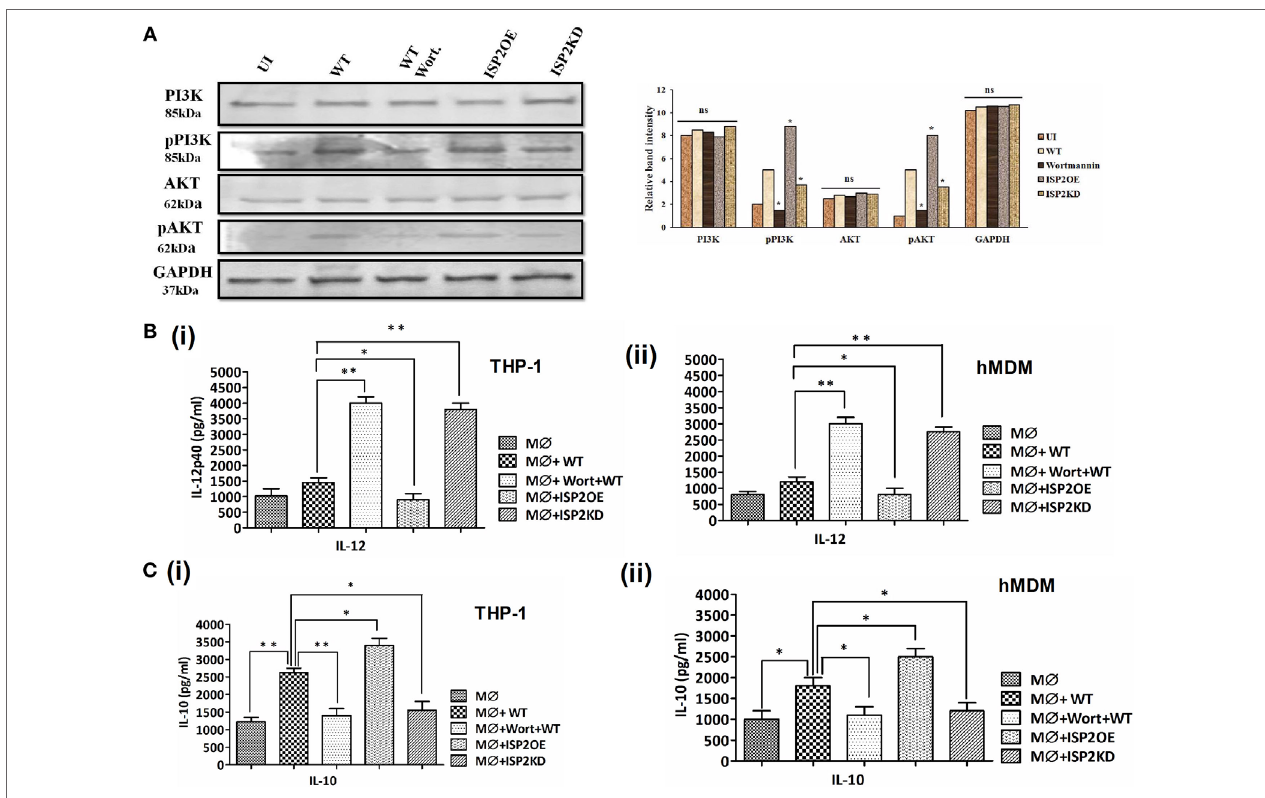
FigUre 9 | Effect of LdISP2 on activation of PI3K/AKT pathway. Macrophages (THP1 or hMDM) were either left untreated or pretreated with wortmannin followed by infection by wild-type (WT), ISP2 overexpressed (ISP2OE) and ISP2KD Leishmania parasites for 12 h. The expression of PI3K, p-PI3K, AKT, and p-AKT was evaluated in THP1 cells at the protein level by western blot (a) . The release level of IL-12 (B) , and IL-10 (c) in the culture supernatant of THP1 monocyte-derived macrophages (B,c) (i) and human monocyte-derived macrophages (hMDM) (B,c) (ii) was measured by sandwich ELISA. Blot image is representative of a single experiment. The experiments were performed in triplicate and the data are means ± SD from three separate experiments. An asterisk (*) denotes P ≤ 0.05, when compared to uninfected or WT infected as applicable. Evaluation of the statistical significance of the data was performed by Kruskal–Wallis with Dunn’s multiple comparison